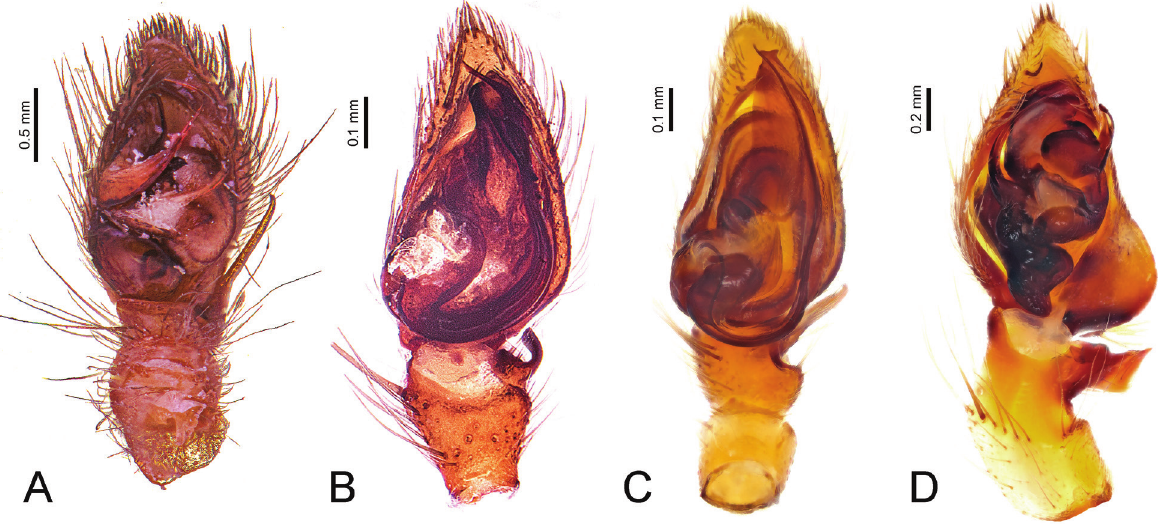
Figure 2. Male palps of gnaphosids, ventral view. A. Minosiella intermedia Denis, 1958; B. Odontodrassus aravaensis Levy, 1999; C. Odontodrassus mundulus (O. Pickard-Cambridge, 1872); D. Pterotricha dalmasi Fage,